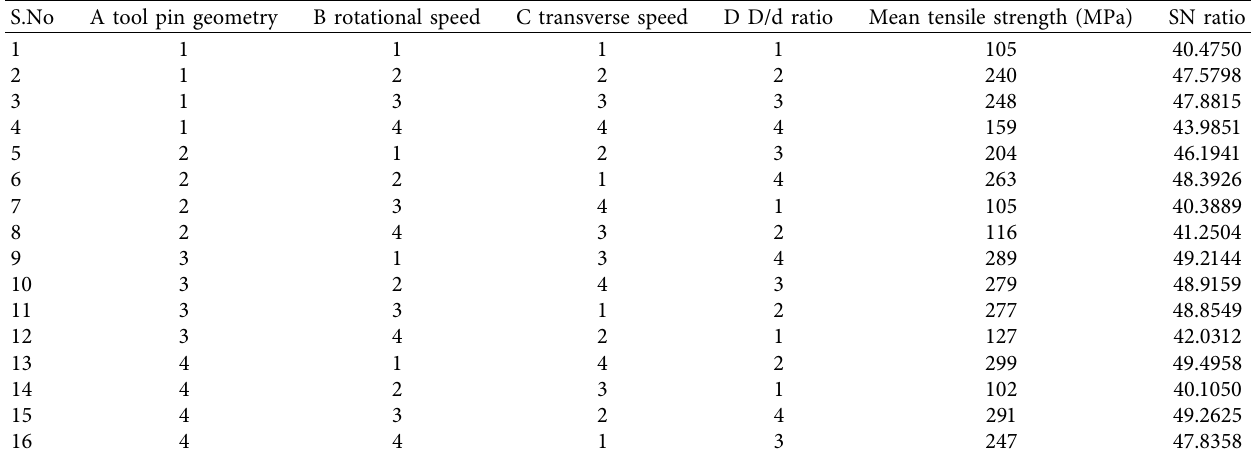
Table 4: L16 orthogonal array with a mean value and SN ratio measurement.